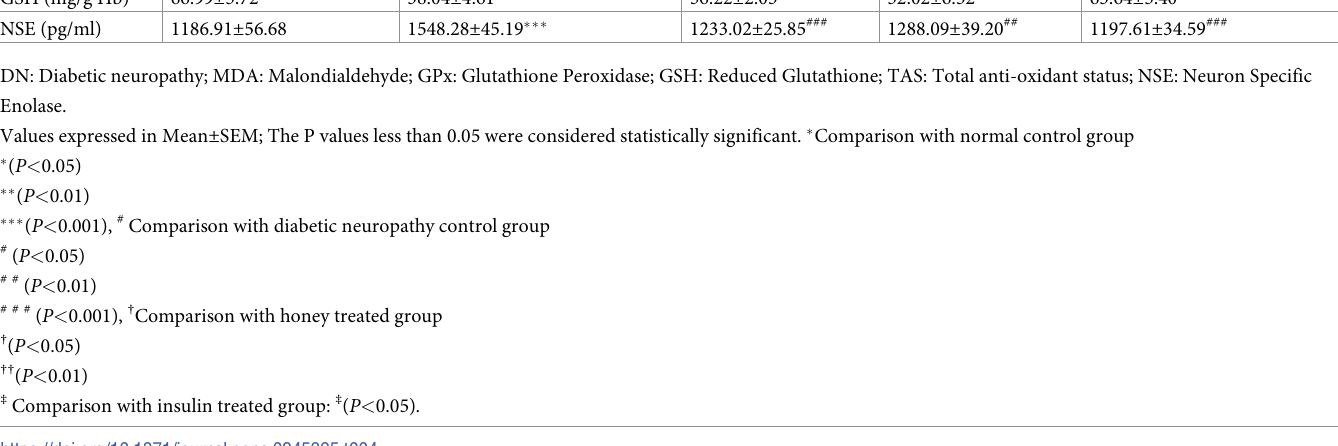
compared with DN with no treatment group. GSH was significantly increased in honey+ insulin treated group alone, when compared with DN with no treatment group. TAS was remained significantly less in DN+insulin group, when compared to DN+honey and DN +honey+insulin group (Table 3). The pre-post percentage change in oxidative stress parame- ters and NSE are depicted in Figs 4 and 5. TAS showed significantly more percentage change in all the treatment groups when compared to DN with no treatment group. Also, when insu- lin group was compared to honey group, the percentage change in TAS was significantly less (p < 0.05). MDA showed significantly more percentage change in DN+honey and DN+honey +insulin groups (p < 0.05), when compared to DN with no treatment group. NSE showed